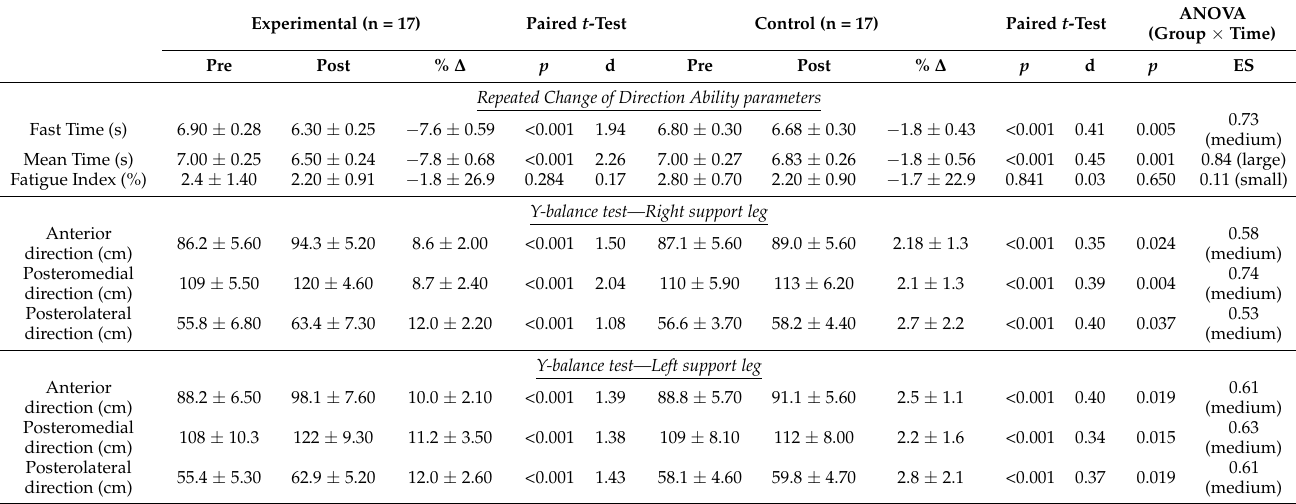
Table 5. Repeated change of direction and Y balance test performances in experimental and control groups before and after 8-week